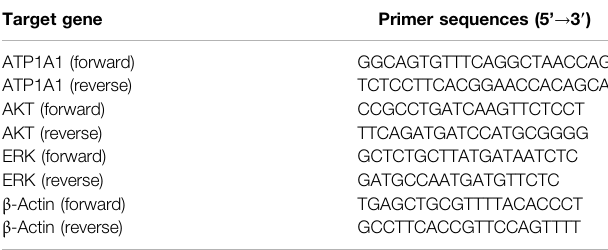
TABLE 1 | Primer sequences of target genes. Target gene Primer sequences (5 ’ → 3 9 )